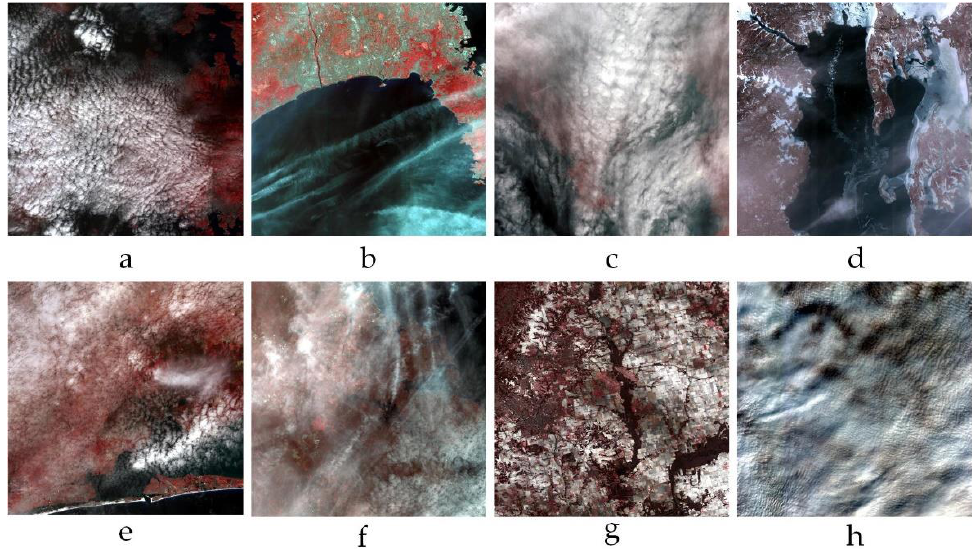
Figure 1. Analysis diagram of some challenging examples of cloud detection in remote-sensing images, featuring: ( a ) a certain degree of integration between clouds and ground objects; ( b ) thin cloud not calculated as part of the cloud amount; ( c ) cloud obscuring almost all the ground objects; ( d ) ice and thin clouds that can be easily confused; ( e ) thick clouds, thin clouds, ice, and snow; ( f ) thin clouds evenly distributed throughout the whole image; ( g ) mainly snow and ice; ( h ) thick cloud almost completely covering the whole image.